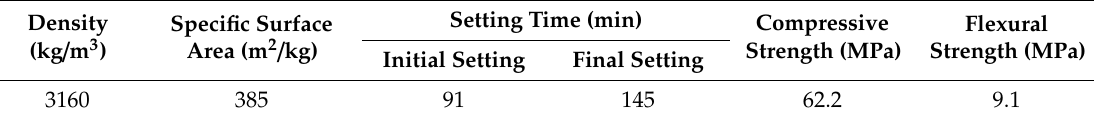
Table 1. Basic properties of cement.